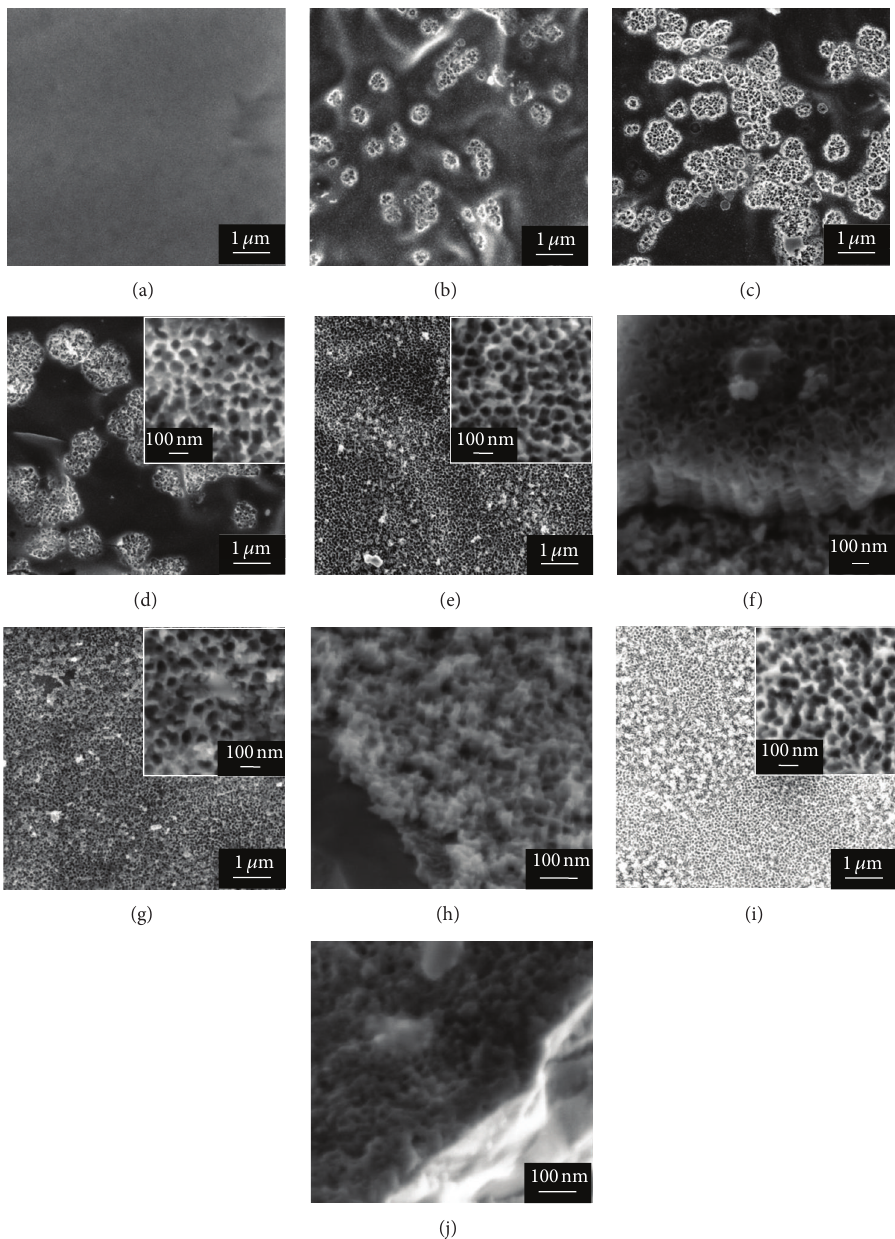
Figure 1: FESEM images of anodic WO 3 nanostructures obtained in 1M Na 2 SO 4 electrolyte containing 0.5 wt% NH 4 F for different anodization times at 40 V: (a) pure W foil before anodization; (b) 2 min; (c) 5 min; (d) 10min; (e) 15min; (f) cross-sectional view for 15min anodization; (g) 30 min; (h) cross-sectional view for 30 min anodization; (i) 60min; (j) cross-sectional view for 60min anodization. Insets show the higher magnification of the surface